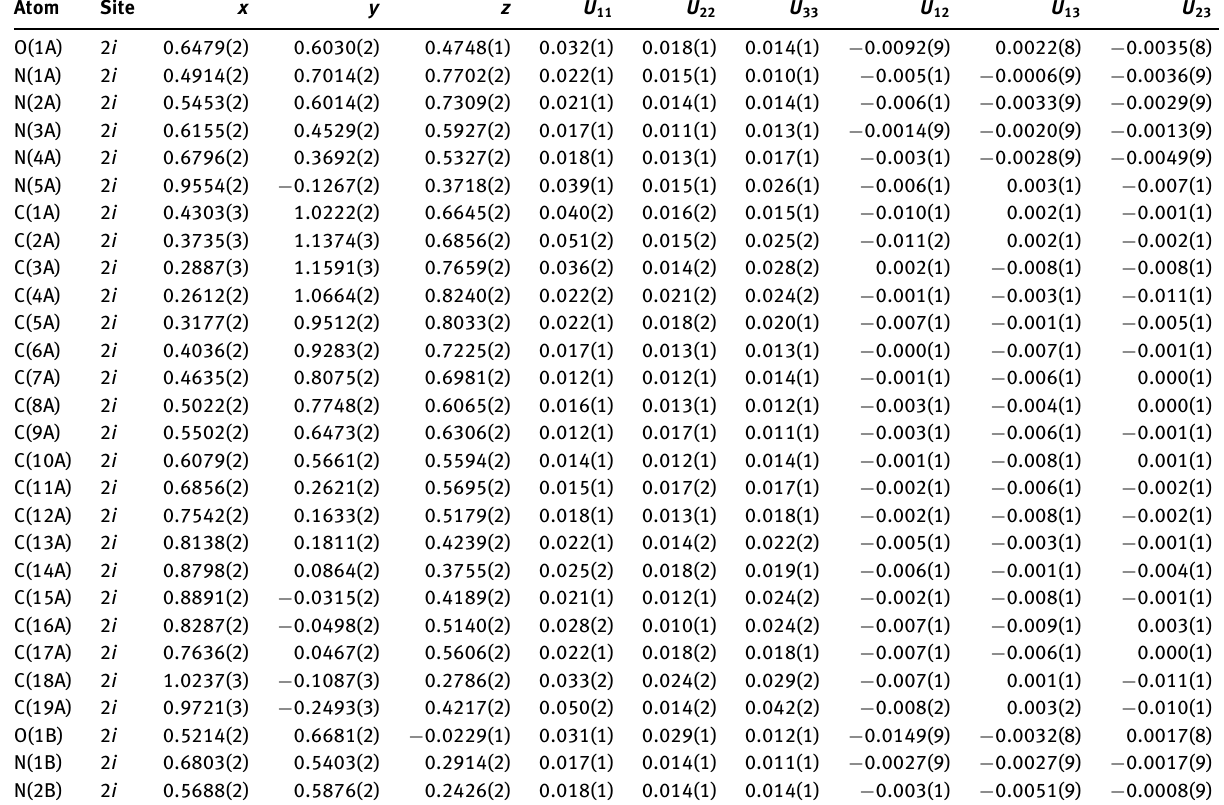
Table 3: Fractional coordinates and atomic displacement parameters (Å 2